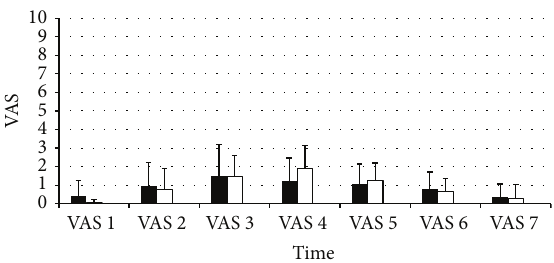
Figure 2: Postoperative VAS pain scores. VAS: visual analog